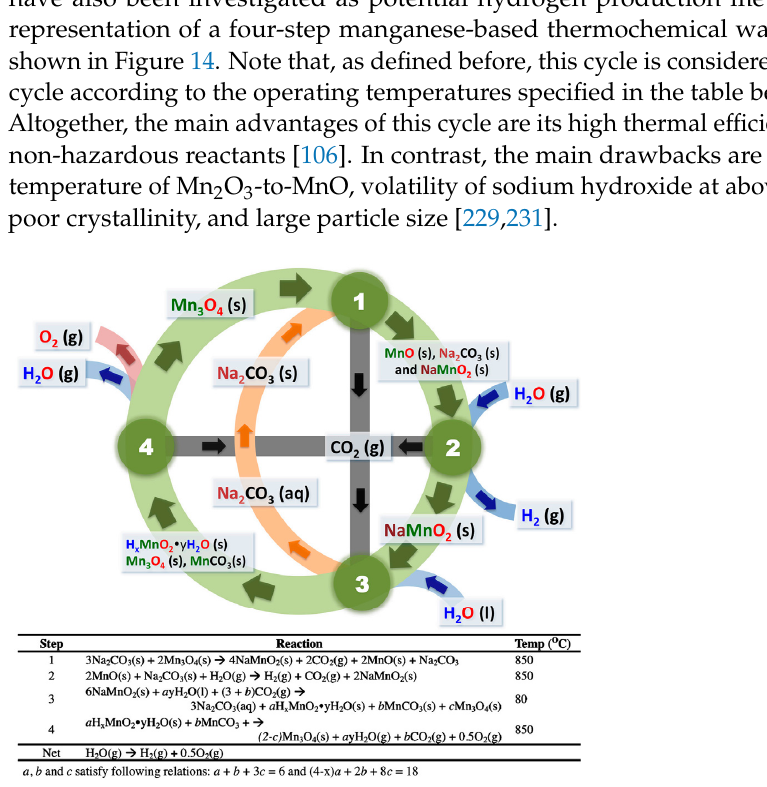
Figure 14. A sample representation of manganese oxide-based thermochemical water splitting cycle for hydrogen generation [233].